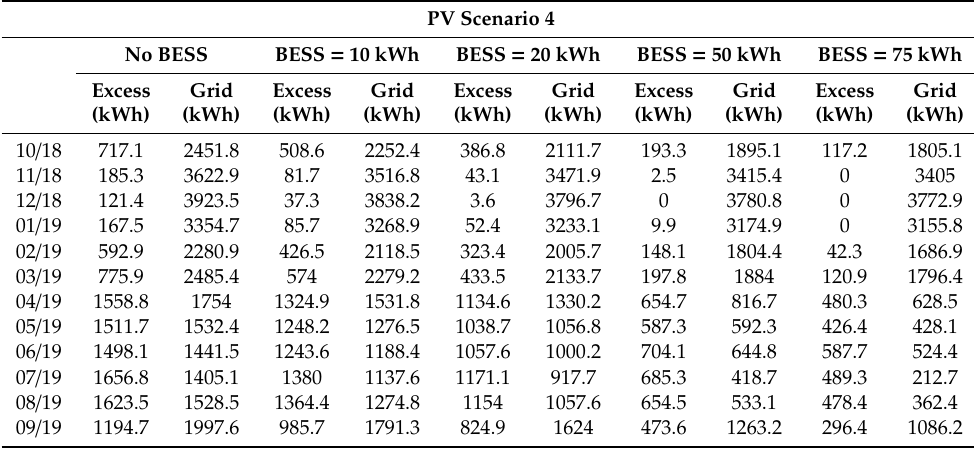
Table A4. Energy sent / taken to / from the grid considering various BESS capacities obtained for PV Scenario